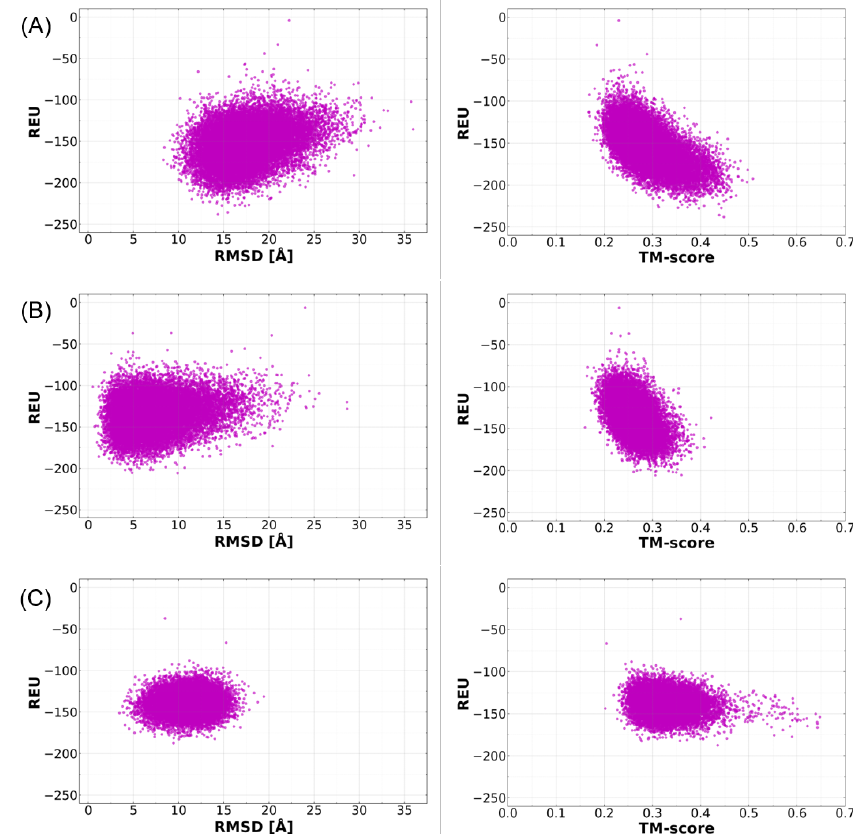
Figure 3. Scatter plots of the distribution of Rosetta energy scores (in Rosetta energy units (REU)) versus RMSD ( left panel ) and TM-score ( right panel ) of ToxA-like effector templates ToxA ( A ), Avr2 ( Fol ) ( B ), and AvrL567 ( C ). RMSD was calculated as the average deviation between the Cα of all residues in each model and the native structure (in Ångstrom). TM-score values above 0.5 indicate similarity in fold between the ab initio model and the native structure. Plots were derived based on structural models obtained with the highest nstruct of 50,000 models per run, and only models with negative REU values were included in the analysis.